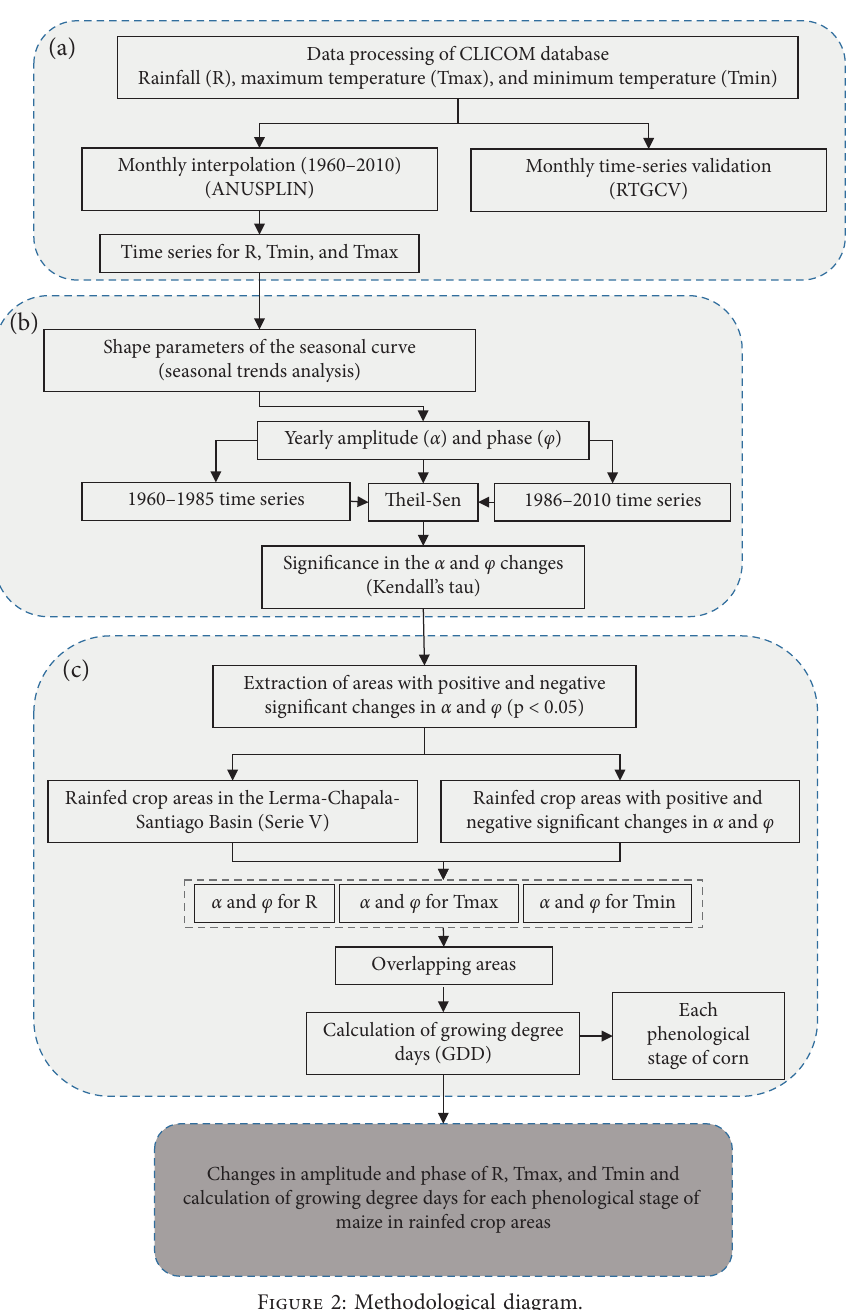
Figure 2: Methodological